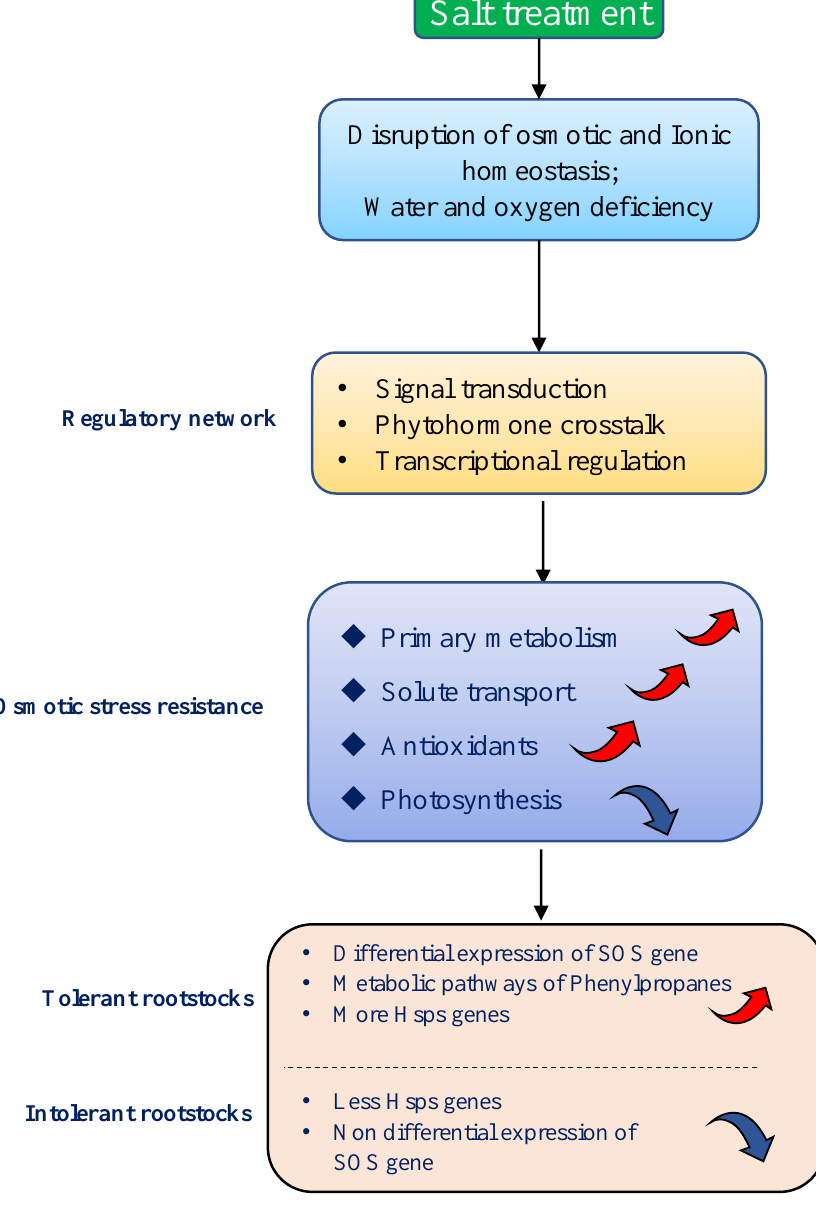
Figure 7. Model of rootstocks in response to salt